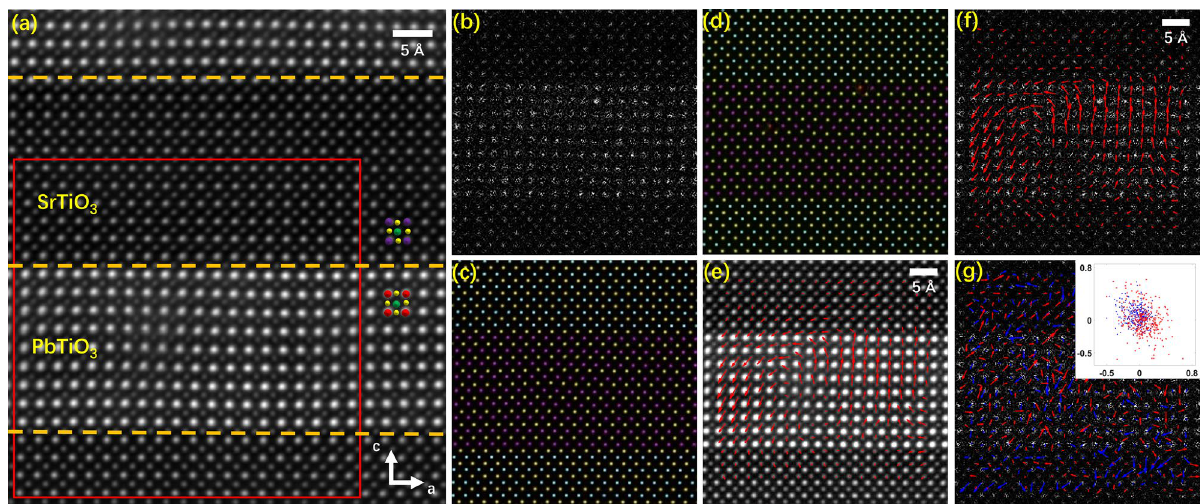
Figure 5. Probability map with element discernment and atom displacement vector map on STEM images of PbTiO 3 /SrTiO 3 superlattice. ( a ) One experimental STEM image of PbTiO 3 /SrTiO 3 superlattice in the test set. Purple, red, green, and yellow balls denote the positions of Sr 2+ , Pb 2+ , Ti 4+ , and O 2- columns respectively, and orange dashed lines indicate the interface between PbTiO 3 and SrTiO 3 . ( b ) The compressed image simulated from the red region of ( a ). ( c , d ) Probability maps with element discernment and ( e , f ) Ti atom displacement vector maps relating to polarization, corresponding to the red region of ( a ) and predicted from experimental STEM images in ( c , e ) traditional mode and ( d , f ) compressed mode. ( g ) The magnified displacement of each position was obtained by comparing ( d ) with ( c ). The inserts are the absolute displacements of all positions with units of pixels. Red and blue arrows (dots) represent the Ti and Pb/Sr sites,